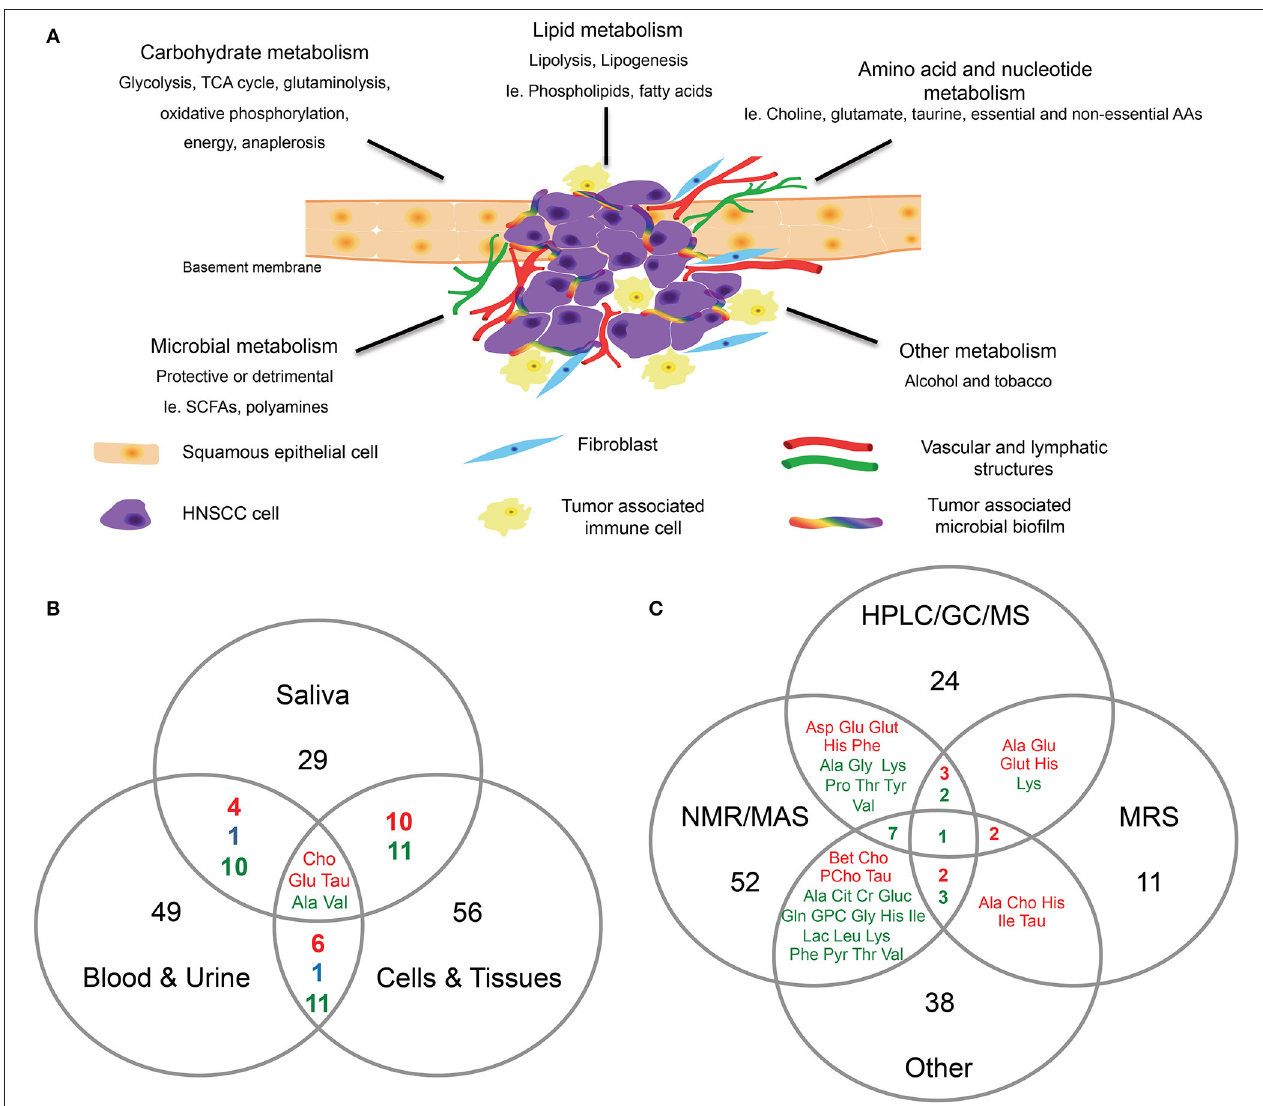
FIGURE 1 | Head and neck cancer metabolism. (A) Proposed schematic representation of HNC tumor microenvironment. Altered metabolism in HNC can result in differential expression of metabolites associated with carbohydrates, lipids, amino acids, and nucleotide metabolism. The co-inhabiting microbiota of the TME can further result in altered metabolic activity. In addition to the genomic transformation of cancer cells, diet and lifestyle (alcohol, tobacco) are risk factors contributing to the altered cancer metabolism. (B,C) Venn diagrams showing, (B) Overlap of differentially expressed metabolites identified in HNC in saliva, blood and urine, and cells and tissues. (C) Overlap of differentially expressed metabolites in HNC identified by different detection methods such as HPLC/GC/MS, NMR/MAS, MRS and other. Metabolites were selected and compiled from studies in Table 1 . Red, detected in increased levels; Blue, detected in decreased levels; Green, detected in increased and decreased